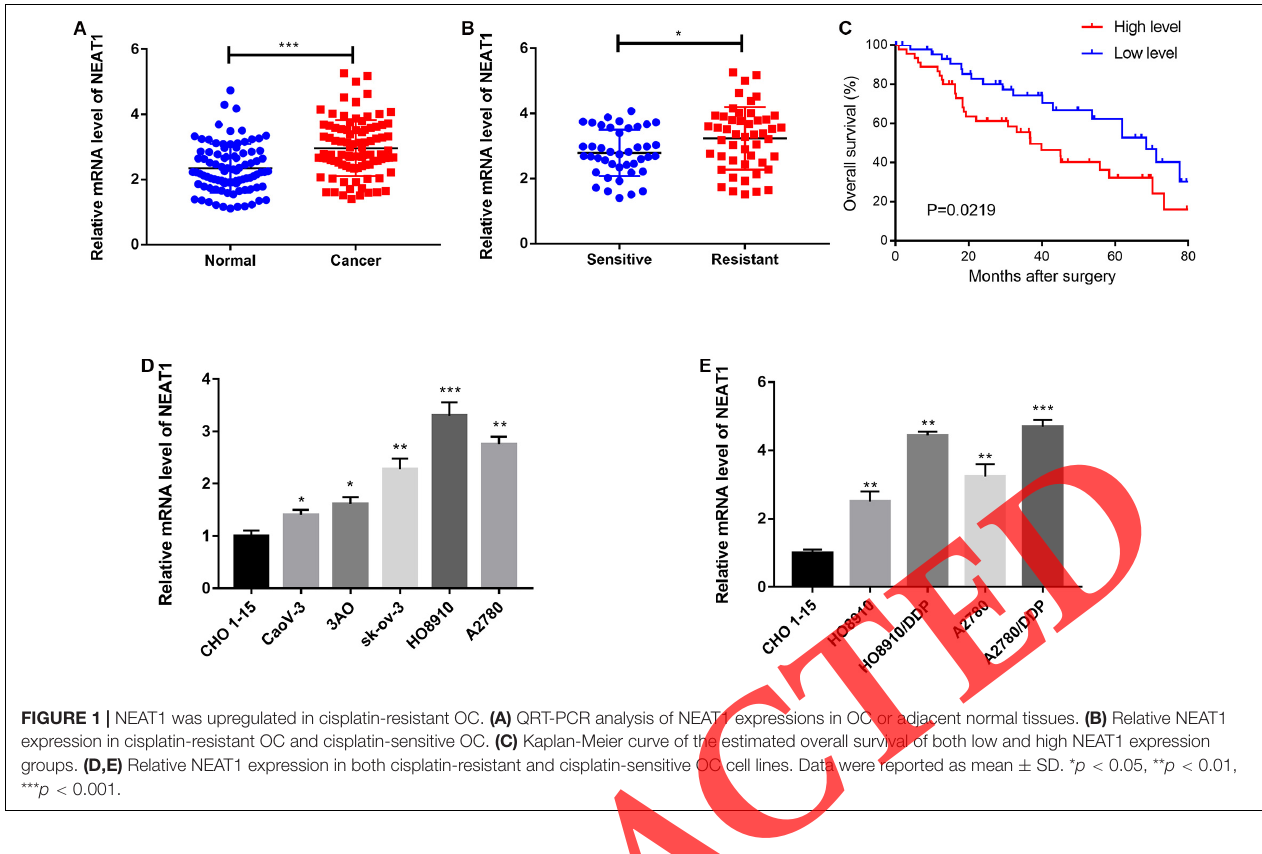
TABLE 1 | Correlation between NEAT1 and clinicopathological characteristics in OC